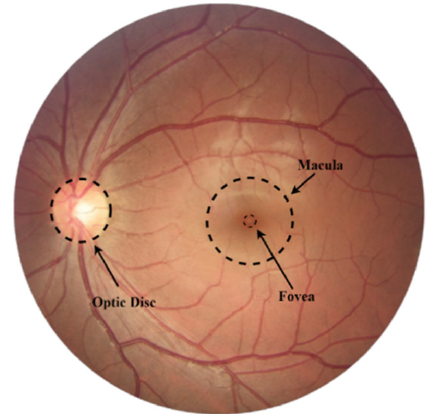
Figure 2. Human retina.